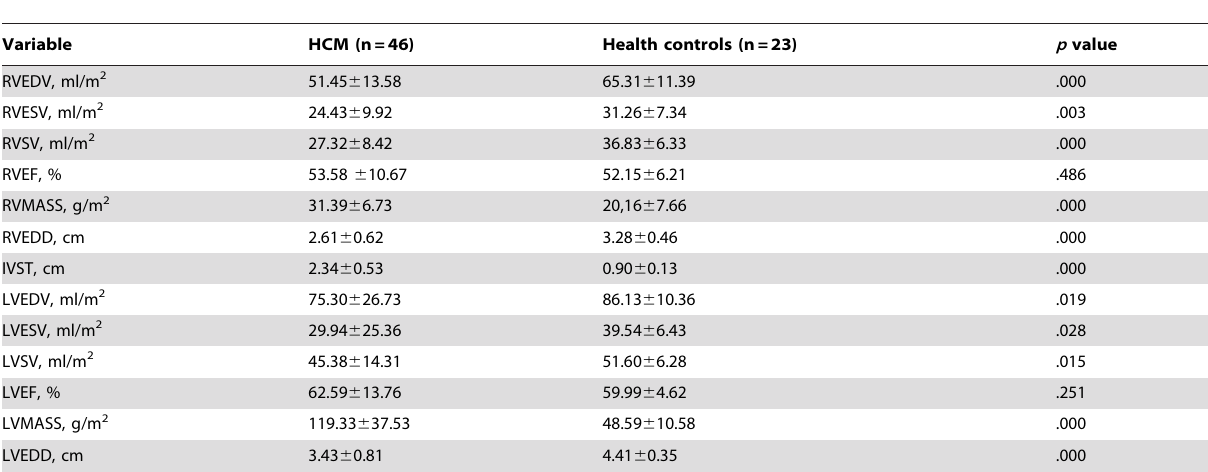
Table 2. RV and LV function and size parameters of HCM patients and normal individuals.